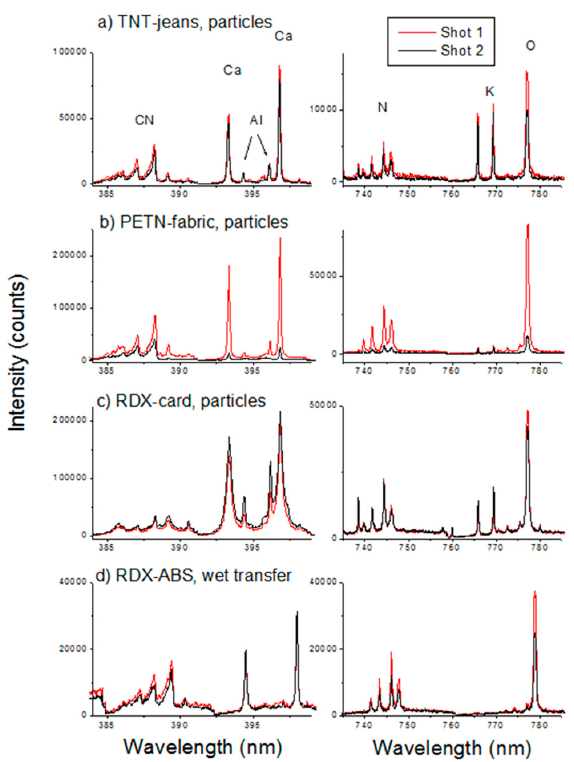
Figure 10. Single-shot LIBS spectra in intervals containing CN molecular features (left panel), N I, O I emission (right panel), for explosives in the form of particles ( a – c ) or delivered by a wet transfer ( d ) and O I (right panel) emission, for explosives in the form of particles ( a – c ) or delivered by a wet on di ff erent organic transfer ( d ) in different organic substrates.